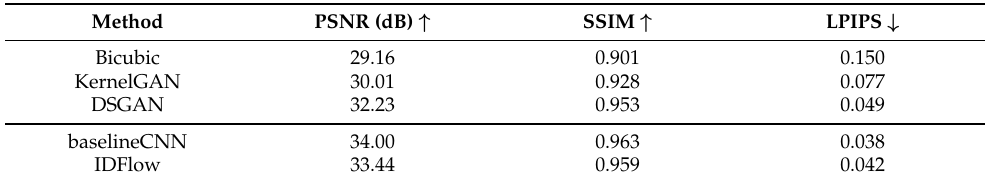
Table 2. Degradation performance of different image degradation modeling methods on RealSR-Test with 4 × down-sampling. ↑ indicates that the higher the value, the better the result. ↓ indicates that the lower the value, the better the result.